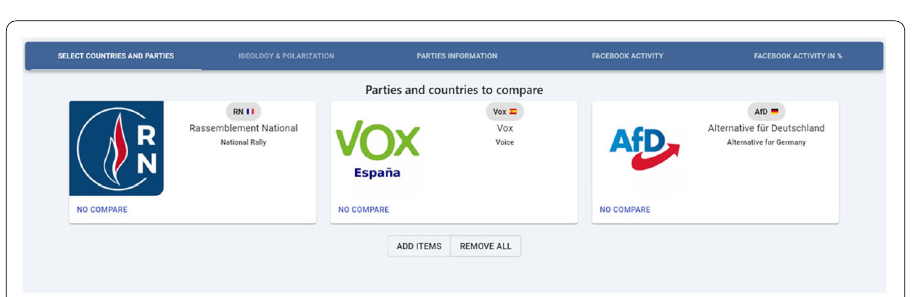
Figure 12 Selection of parties to compare